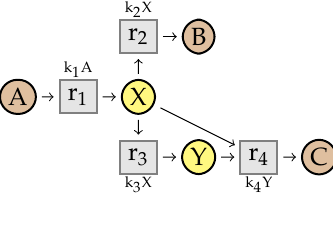
Figure 21. Example illustrating the need of Condition